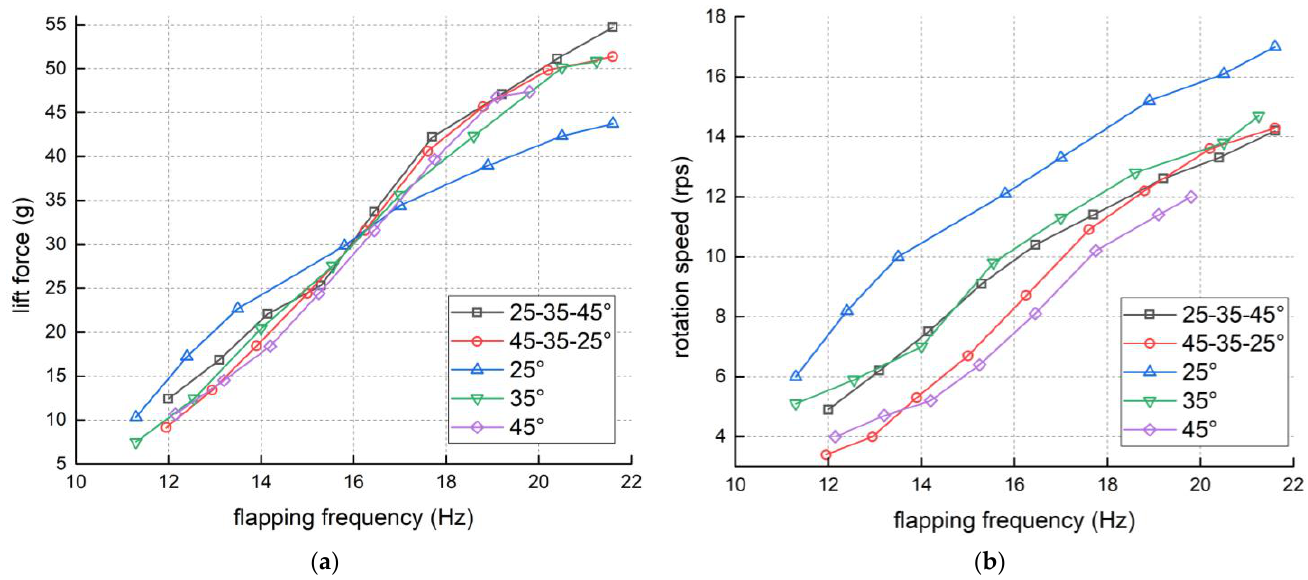
Figure 16. The influence of 10° wing torsion of the FWR: ( a ) Flapping frequency-lift force line chart; ( b ) flapping frequency-rotation speed line chart.